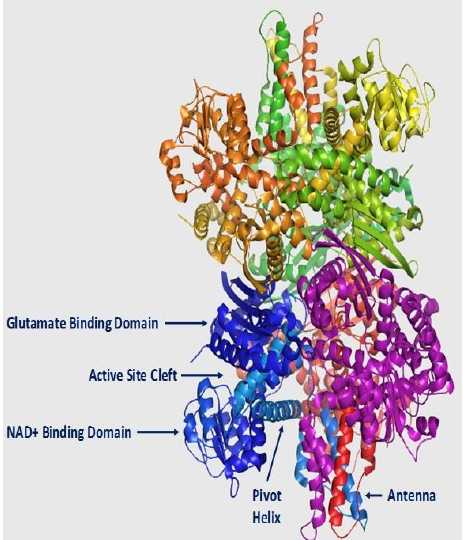
Figure 2. Structural model of hGDH1. Shown is a cartoon diagram of the apo form of the hGDH1 hexamer (PDB code: 1L1F), where each of the six subunits is colored differently. The main parts of the GDH subunit (active site, NAD + binding domain, glutamate binding domain, antenna and pivot helix) are indicated only for the blue subunit. The figure was constructed using the PyMOL